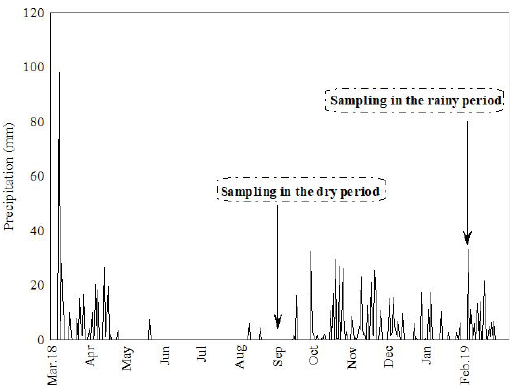
Figure 2. Annual variation of precipitation (mm) in the study region, and sampling during the dry and rainy